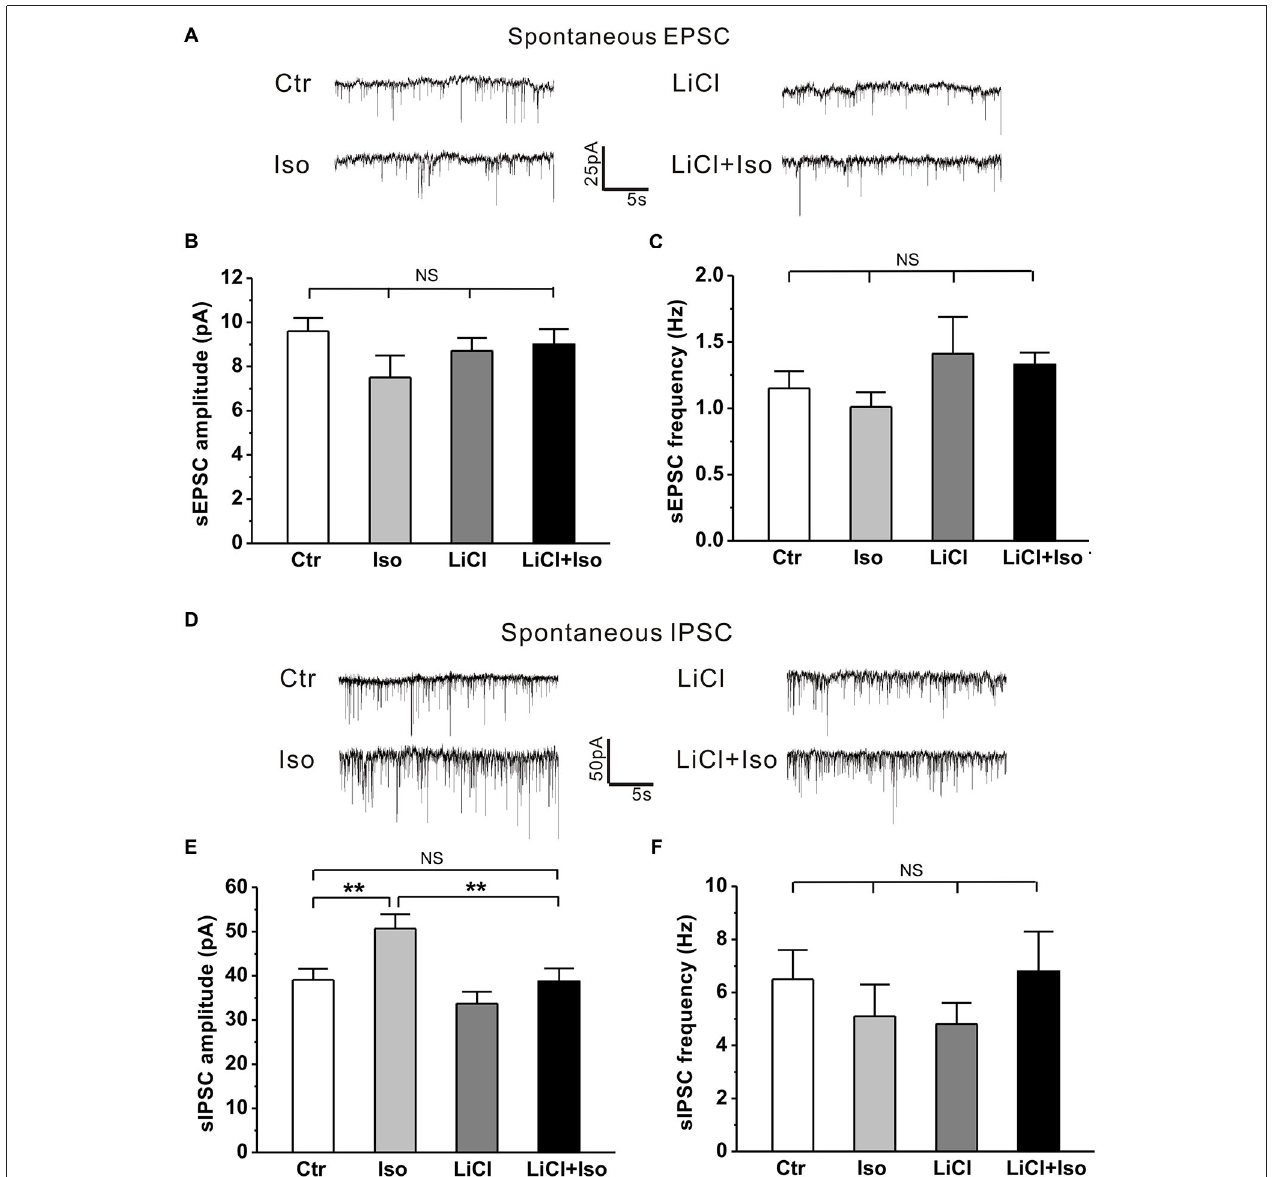
isolation dramatically enhances sIPSC amplitude (E) , but not frequency (F) ; while lithium recues the abnormal enhancement of sIPSC amplitude, and corresponding representative traces are shown in graph (D) . For sIPSC amplitude: treatment × drug, F ( 1,47 ) = 1.253, P > 0.05; treatment, F ( 1,47 ) = 8.143, P < 0.05; drug, F ( 1,47 ) = 8.797, P < 0.05. For sIPSC frequency: treatment × drug, F ( 1,47 ) = 2.210, P > 0.05; treatment, F ( 1,47 ) = 0.057, P > 0.05; drug, F ( 1,47 ) = 0.001, P > 0.05. Data show mean ± SEM (* p < 0.05; ** p <